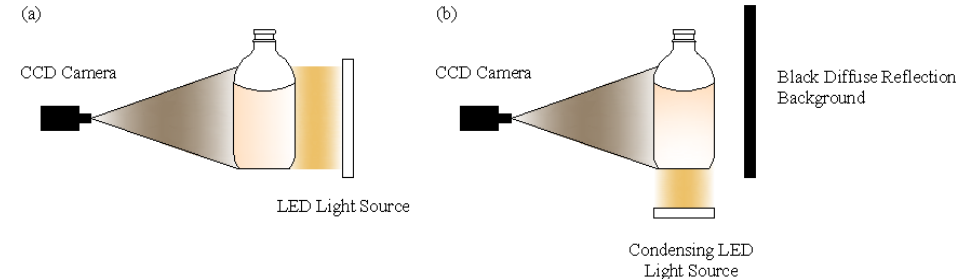
Figure 6. Illumination Styles: (a) Silhouette illumination. (b) Bottom light reflection